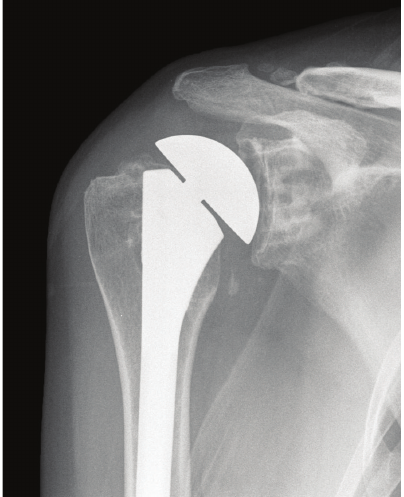
Figure 2: Anterior-posterior radiograph of the patient’s right shoul- der taken seven months after the index TSA. The distance between the acromion and humeral head is not narrowed in this image. This contrasts with the later radiograph shown in Figure 3 where this distance is significantly narrowed (which suggests weakness of the superior rotator cuff).